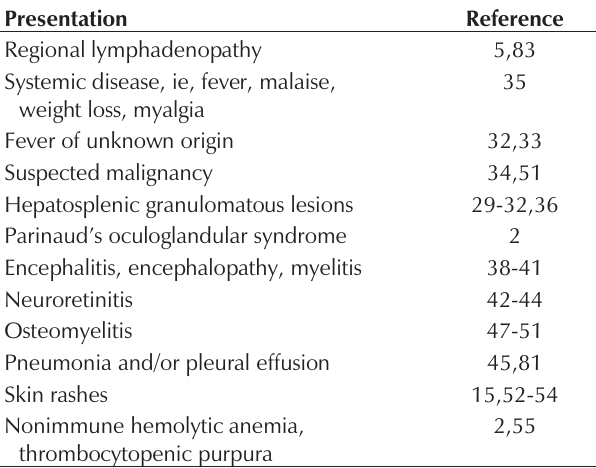
Spectrum of clinical presentation of cat scratch